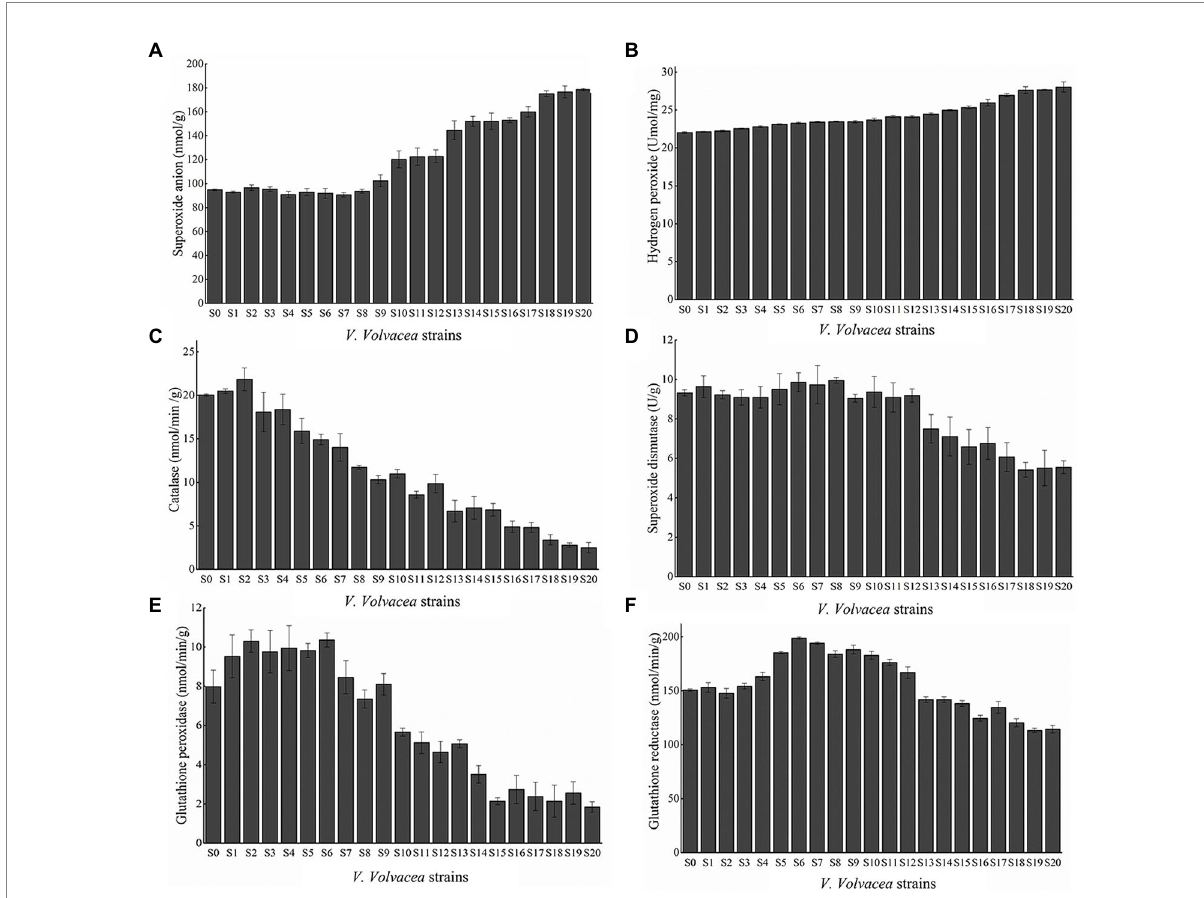
FIGURE 4 ROS content of (A) O 2 − , (B) H 2 O 2 , activities of SOD (C) , (D) CAT, (E) GPX, and (F) GR. Values represent the mean of three measurements ( n = 3), while vertical bars represent the standard deviation.